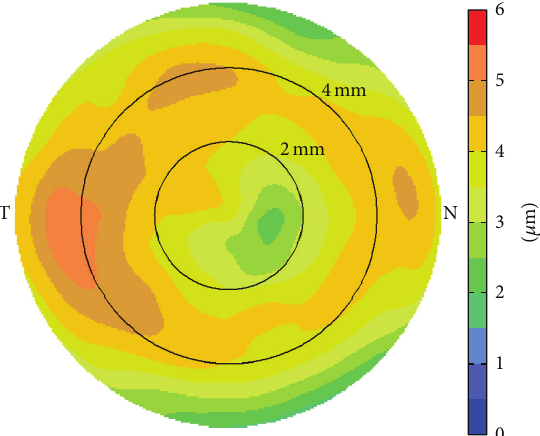
Figure 3: Average epithelial thickness change map after myopic